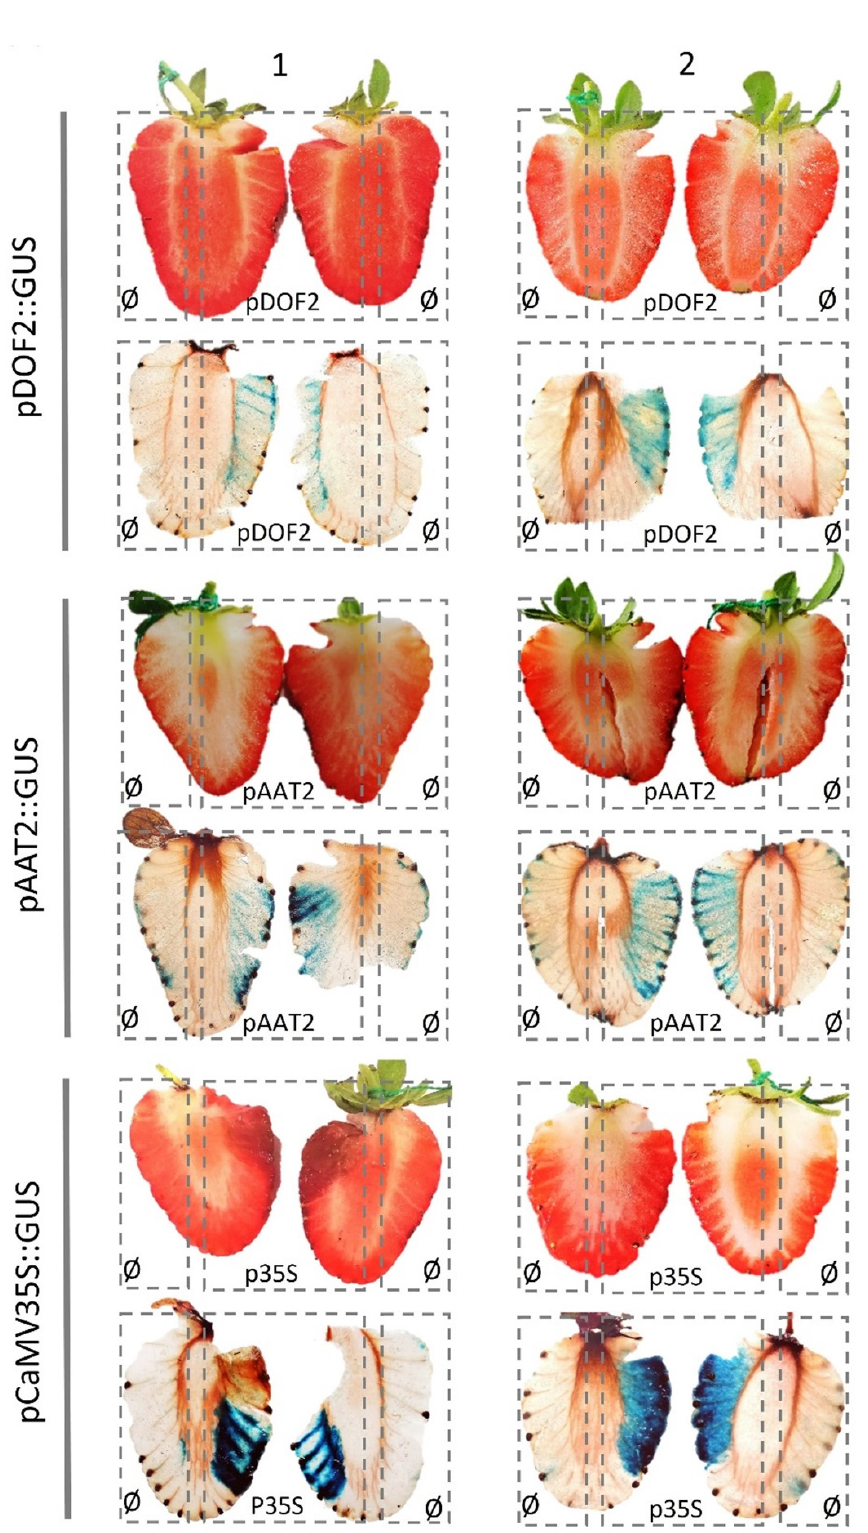
Figure 4. Transient promoter probe analysis of the synthetic FvDOF2 and FvAAT2 DNA fragments, respectively, in F. × ananassa fruit. Numbers 1 and 2 represent two different fruit samples. Histo- chemical GUS staining was performed after 5 days of fruit infiltration with agrobacterium carrying different query promoter constructs ( pFvDOF2 ::GUS, pFvAAT2 ::GUS, and pCaMV35s ::GUS) or the pKGWFS7.0 empty vector as a negative control (Ø). Query promoter constructs were injected in one